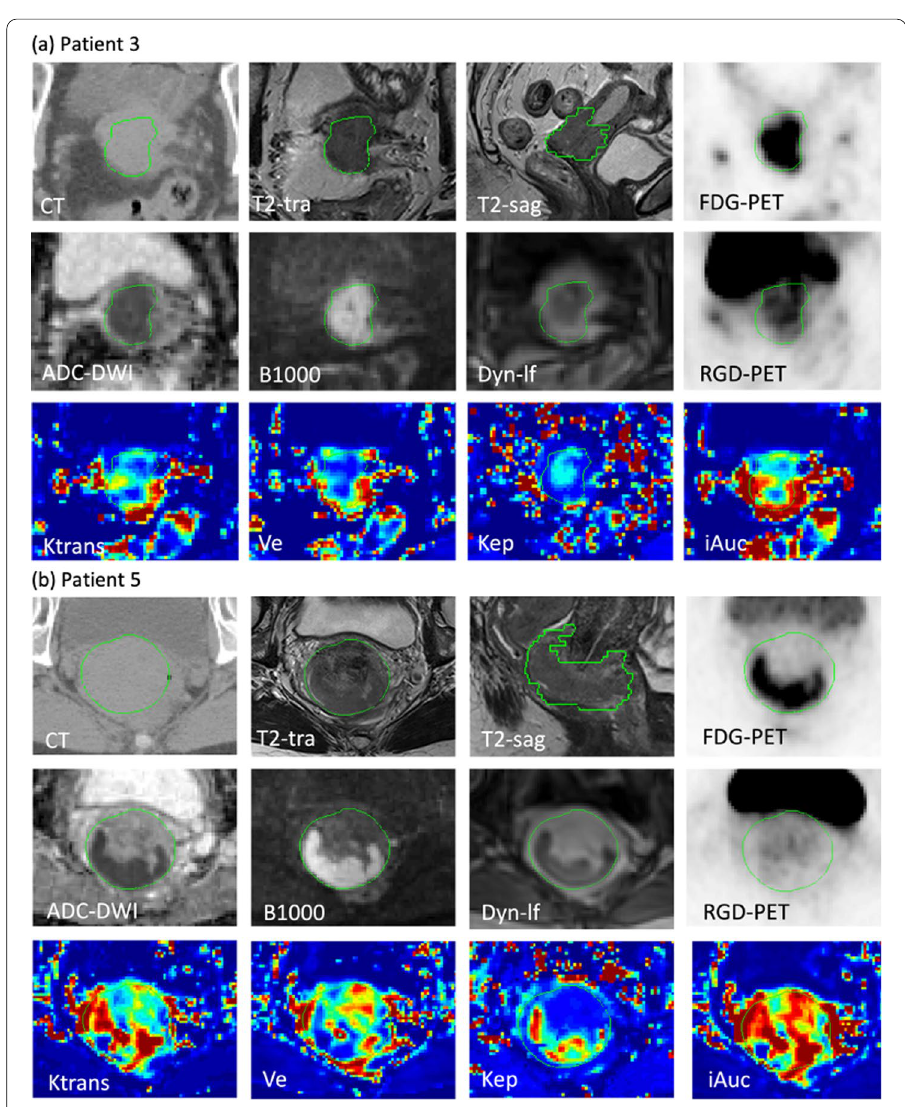
Fig. 1 Representative examples of co-registered parametric maps for patient 3 ( a ) and patient 5 ( b ). From upper left to lower right: planning CT, axial and sagittal T2-weighted MRI, FDG-PET, diffusion parameters (ADC, B1000), last frame of DCE, RGD-PET, and perfusion parameters ( K trans , v e , k ep , and iAUC 60 ). Green contour represents